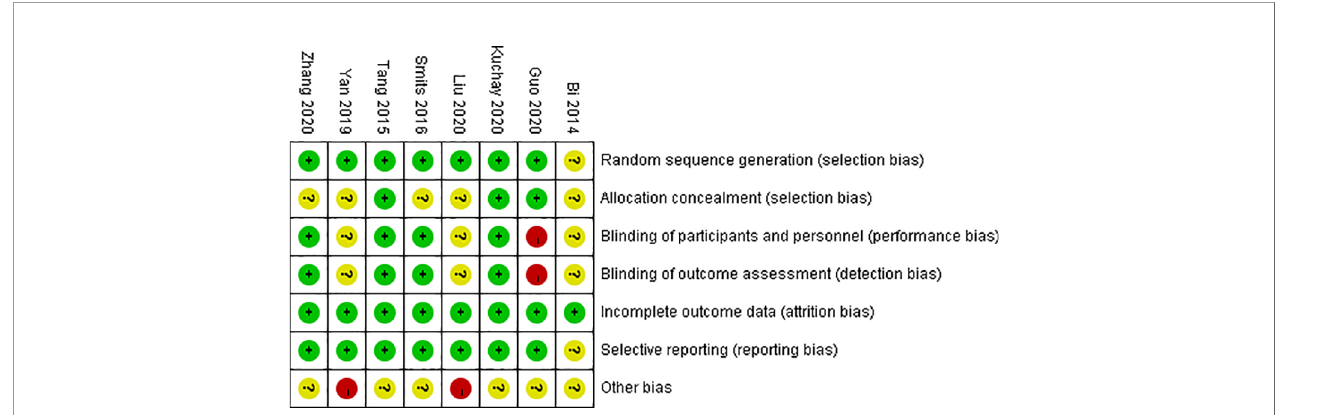
FIGURE 3 | Risk of bias summary: Authors ’ judgements about each risk of bias item for each included study.